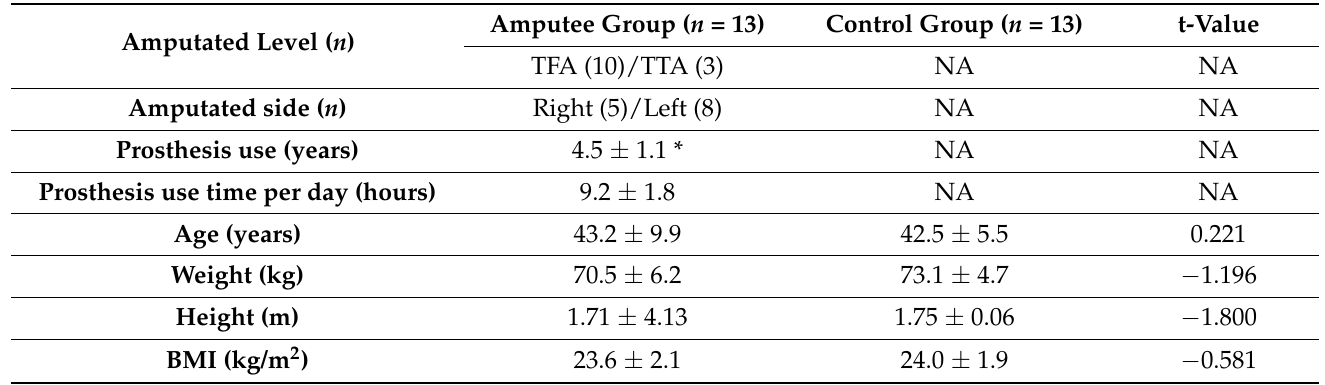
Table 1. General characteristics of the participants ( n = 26).